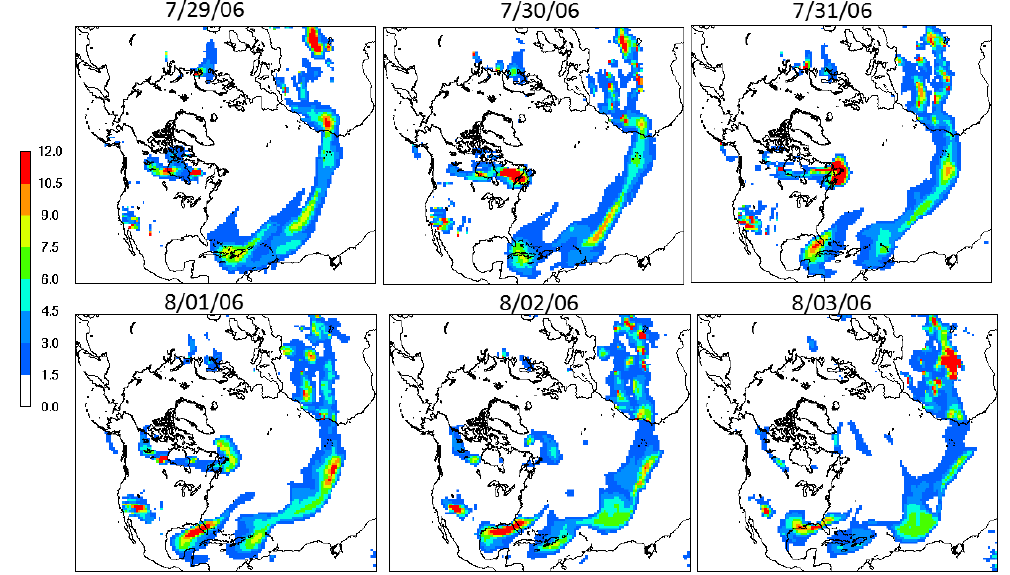
Figure 8. Transatlantic transport of a Saharan dust plume, 29 July–3 August 2006, as simulated by hemispheric CMAQ. Shown in the panels is the difference in daily-average PM 2 . 5 concentrations (µg m − 3 ) between CMAQ simulations with and without considering dust emissions.